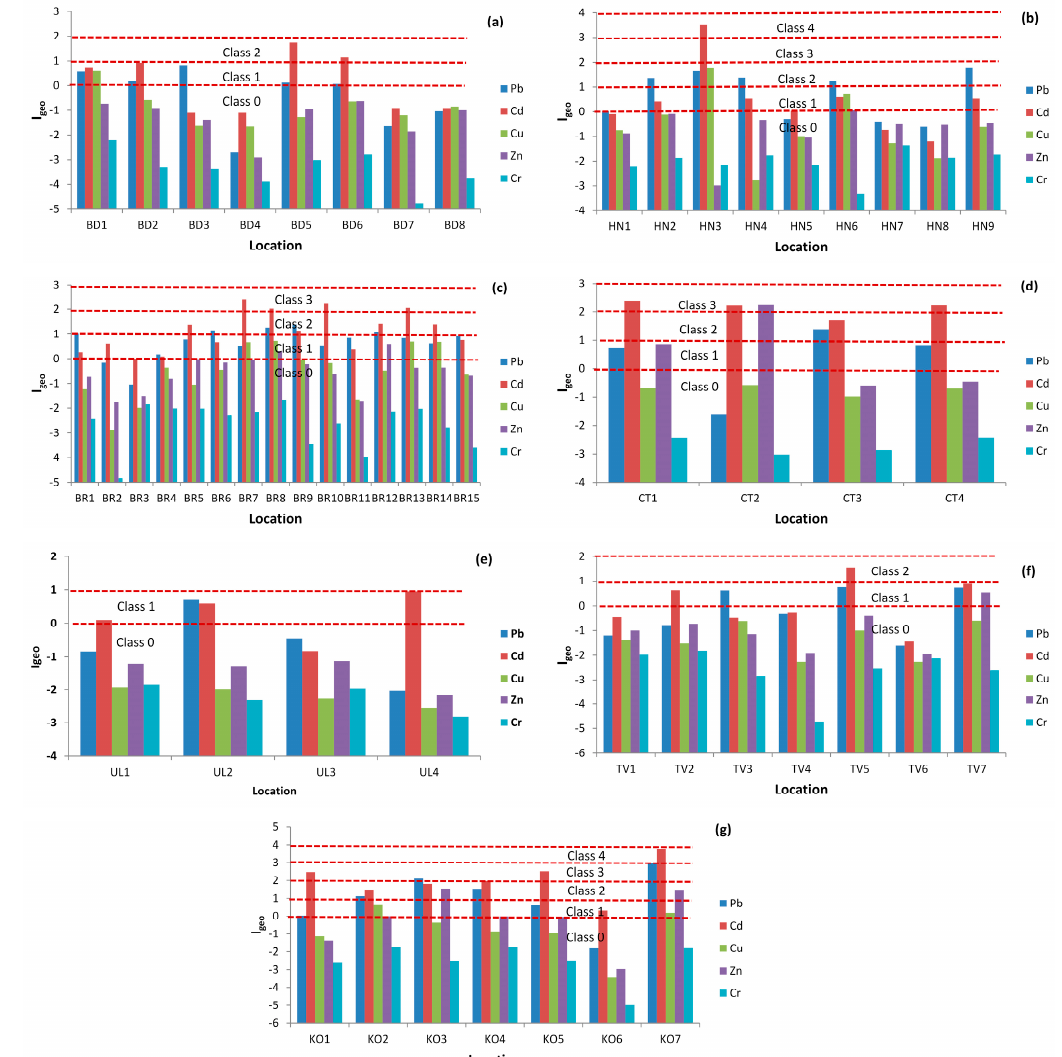
Figure 3. Geo-accumulation index (Igeo) values of heavy metals in urban parks soil samples in coastal municipalities of Montenegro, ( a ) Budva; ( b ) Herceg Novi; ( c ) Bar; ( d ) Cetinje; ( e ) Ulcinj; ( f ) Tivat; ( g ) Kotor.